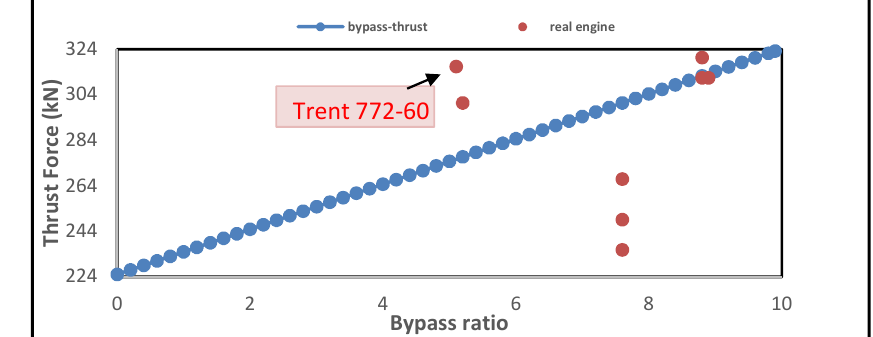
Fig. 2. Trade-off curve one between bypass ratio and engine thrust force with a real engine.